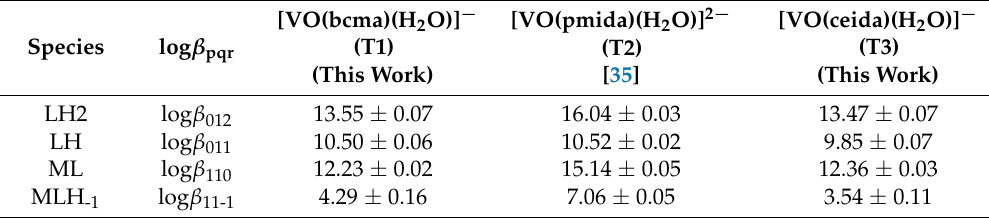
Table 1. Logarithms of the stability constant values (log β pqr ) of the VO(IV) complexes obtained by adapting the equilibrium model to PT data. The corresponding standard deviations are given in parenthesis.